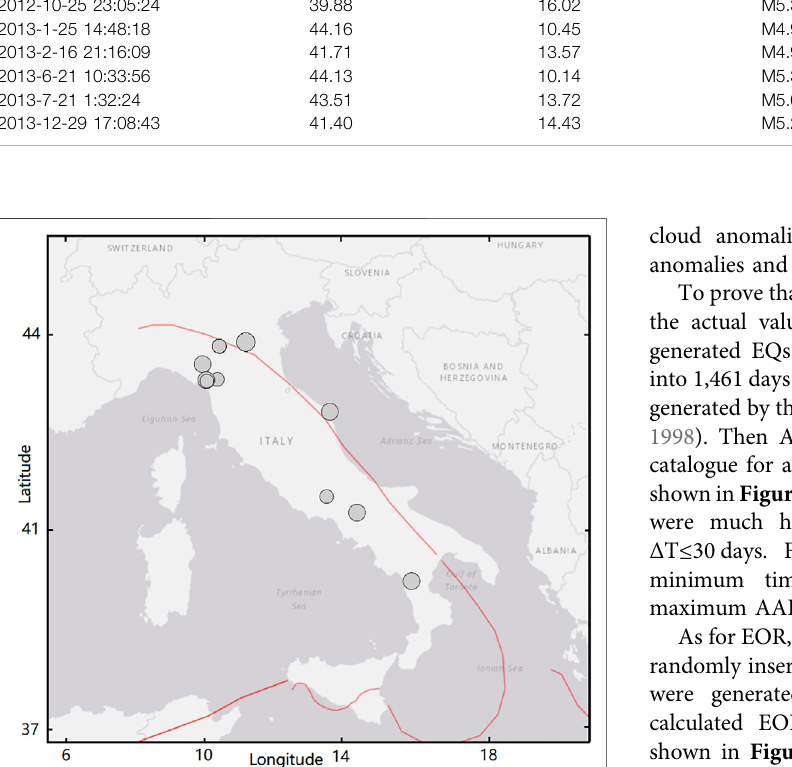
Frontiers in Earth Science |